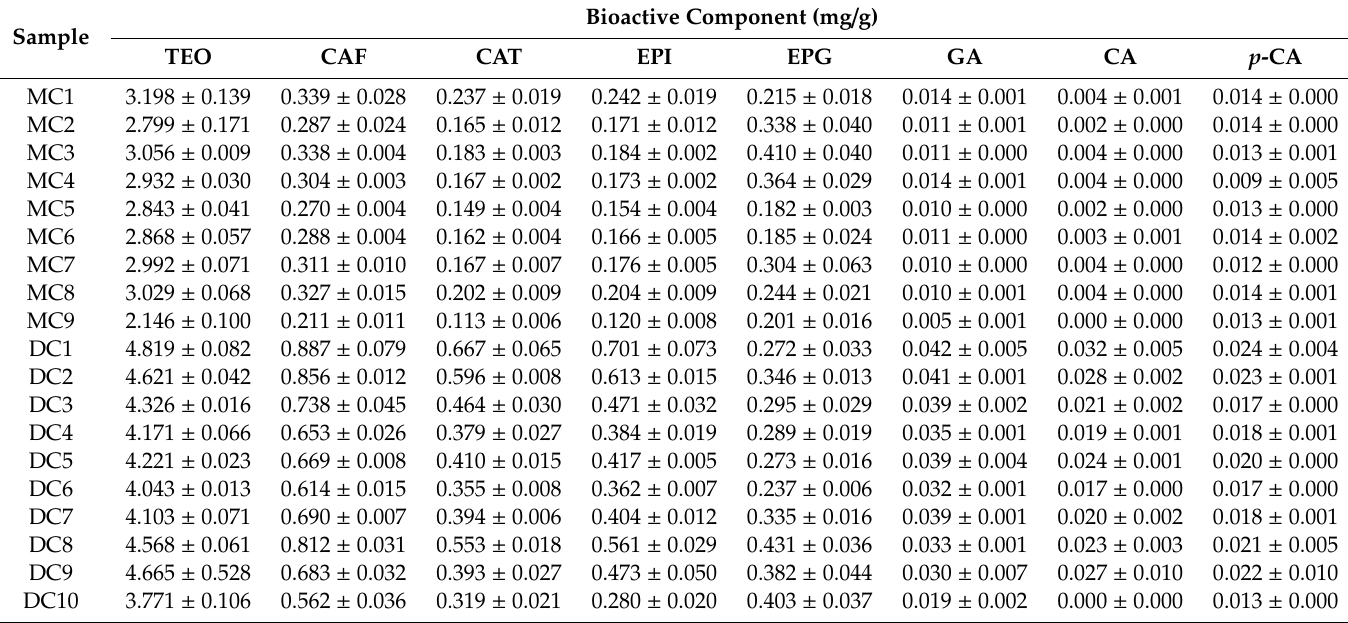
Table 2. The content of methylxanthines and phenolic components in analyzed chocolate samples (average ± standard deviation).